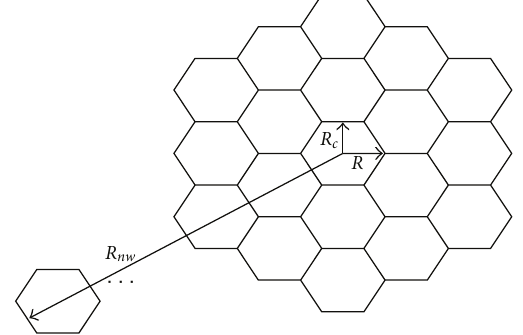
Figure 3: Hexagonal network and main parameters of the